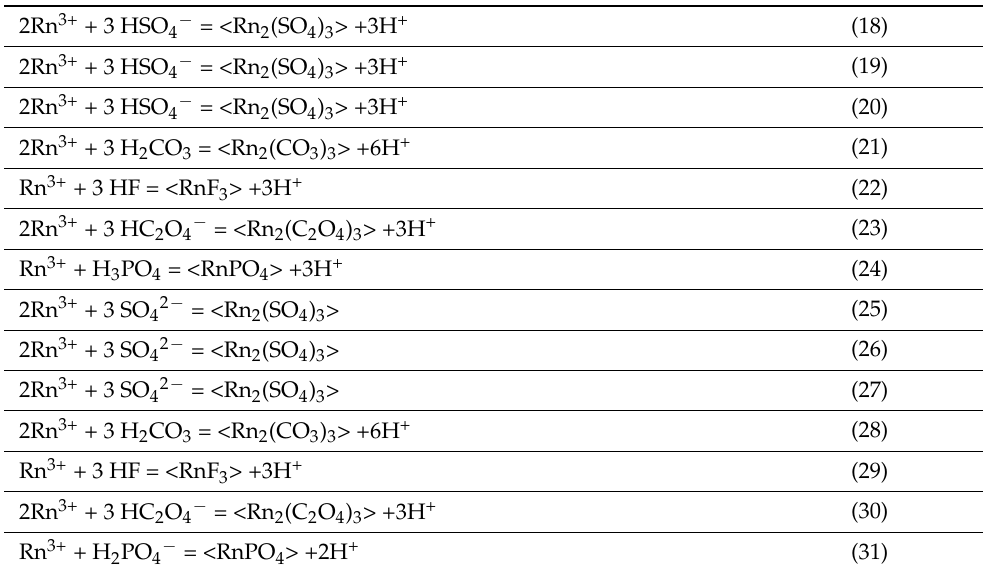
Figure 12. Equilibrium concentrations of Rn 3+ for precipitation into Rn 2 (SO 4 ) 3 at ( a ) pH 1; and ( b ) pH 3, and the results are compared with those of carbonate, fluoride, oxalate, and phosphate (dashed line: 1 ppm line). Table 7. Precipitation equations of Rn 3+ for precipitation into Rn 2 (SO 4 ) 3 at pH 1 (a) and pH 3 (b) and the results are compared with those of carbonate, fluoride, oxalate, and phosphate (equations used in Figure 12).